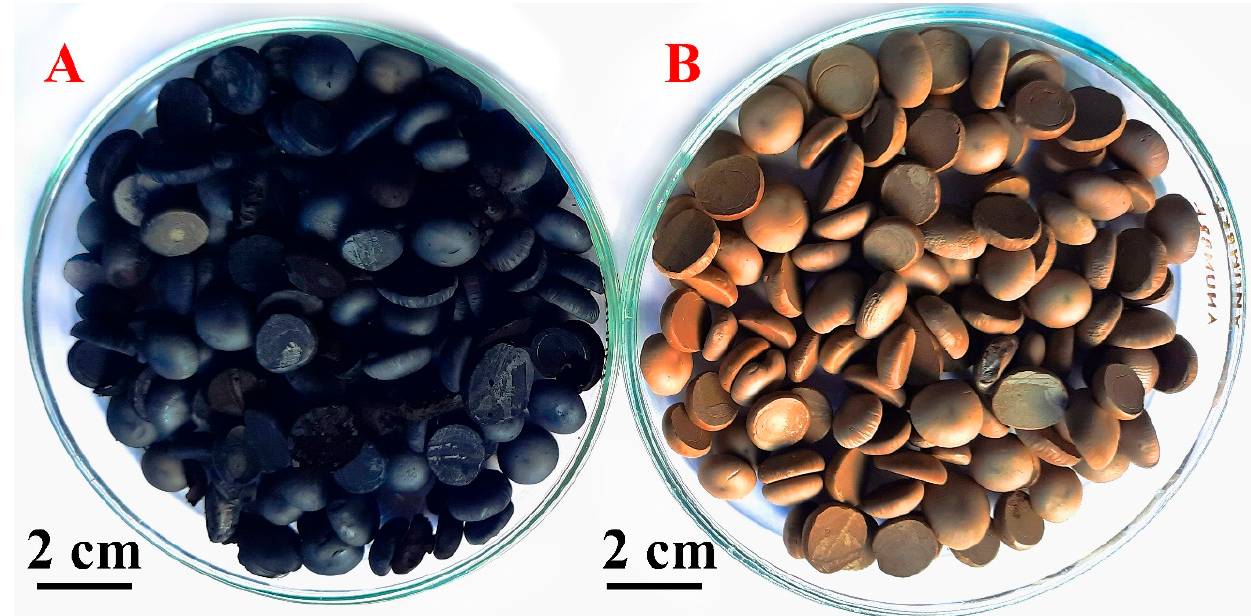
Figure 1. Photographs of composite aerogel after reduction ( A ) and before reduction ( B ).